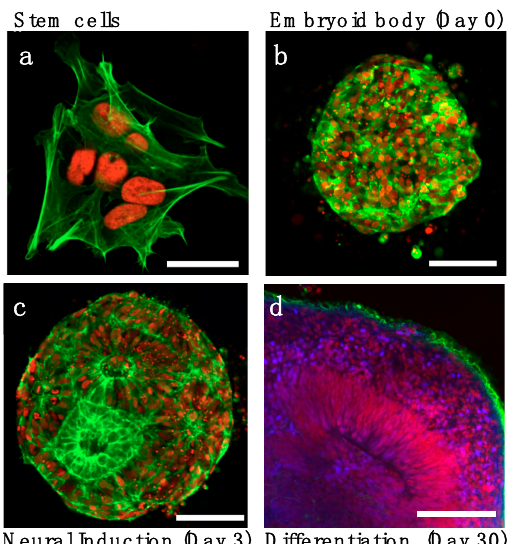
Figure 1. Stages of in vitro organoid development. ( a ) Stem cells with live reporters H2B-mCherry (red) and lifeact-GFP (green) are assembled into ( b ) 3D embryoid bodies. ( c ) Following neural induction, ventricle-like lumens appear within the 3D culture. ( d ) Neural differentiation and layer organization with neuronal progenitor (PAX6+, red) surrounding the lumen, an intermediate layer of sparse progenitors (DAPI, blue) and neuronal layer (TUJ1+, green) on the organoid periphery. Images adapted from Karzbrun et al. [7]. Scale bars are (a) 20 μ m and (b,c,d) 100 μ m.